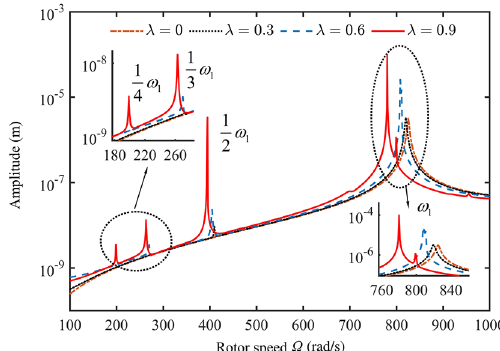
Figure 5 Amplitude-frequency response curves for different crack depths at node 10 ( c p 10) =